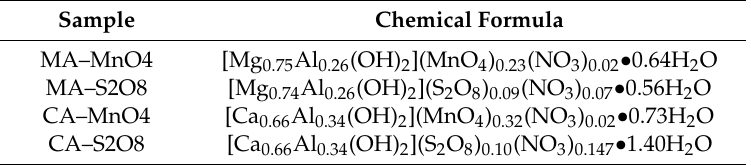
Table 4. Chemical formulae of the synthesized samples. All values rounded to two decimal